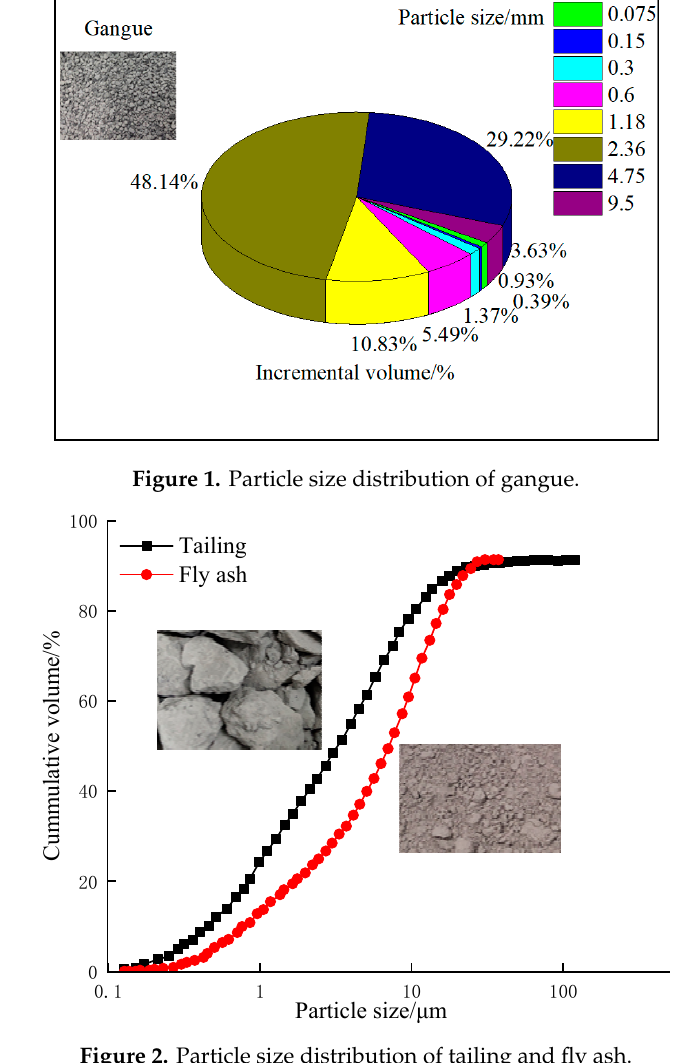
Figure 2. Particle size distribution of tailing and fly ash. Table 1. Physical properties of the materials.